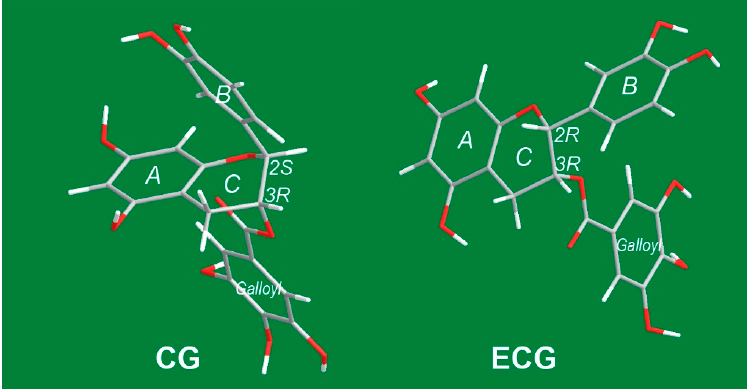
Figure 5. Stick-models of preferential conformations of CG and ECG (Red is for O atom; White is H and gray is C. Double bonds are not shown.).